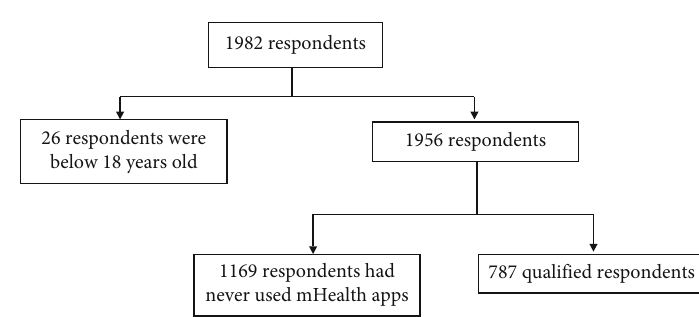
Figure 2: Sampling procedure and